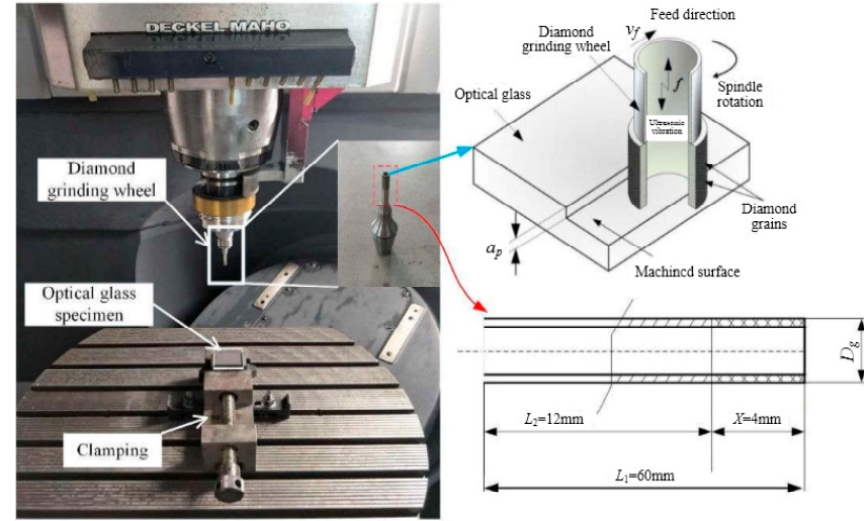
Figure 1. Experimental setup. Table 1. Molar composition, elastic modulus, and Poisson’s ratio of BK7 optical glass.